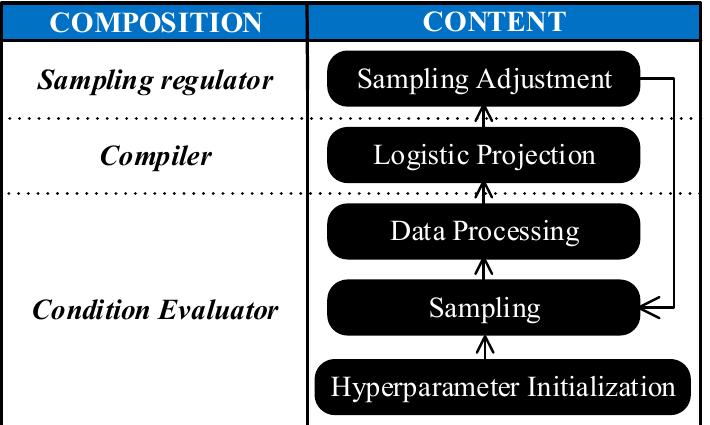
Figure 4. General scheme of condition-based IIS strategy.